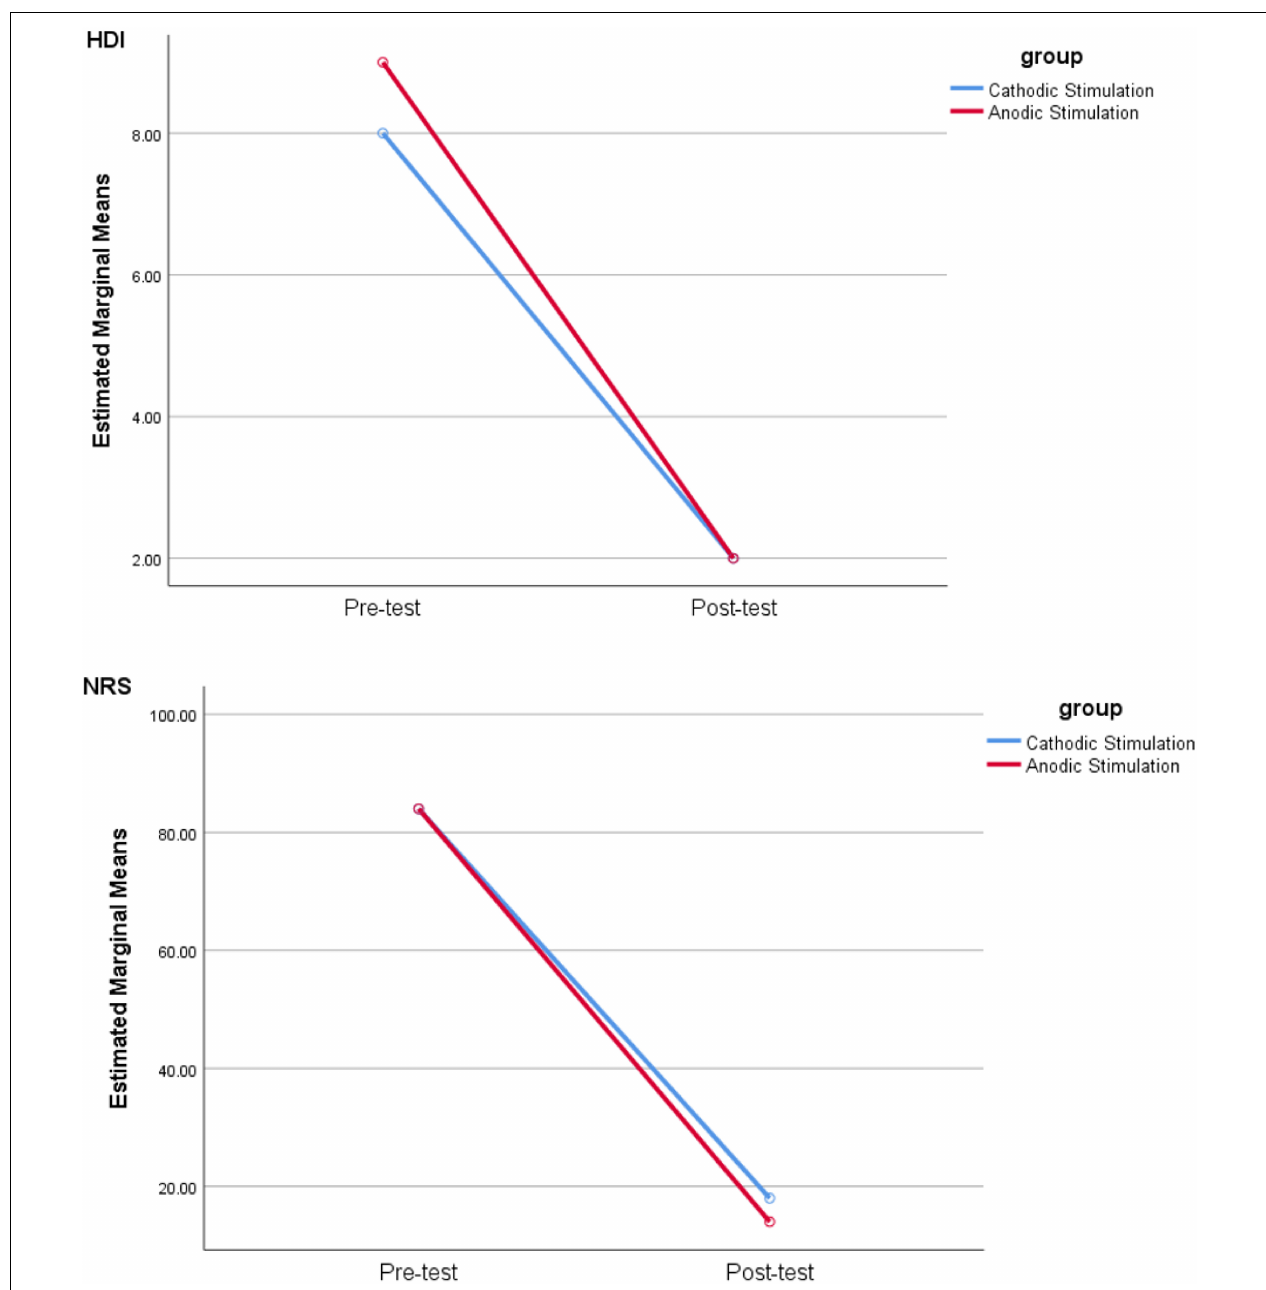
FIGURE 1 | Comparison of HDI and NRS scores in pre- and postsessions by cathodic and anodic stimulation. Note that NRS is used to quantify the severity of pain stipulating “0” as no pain and “10” as the greatest imaginable pain, while HDI provides a score for the level of disability suffered with TN.